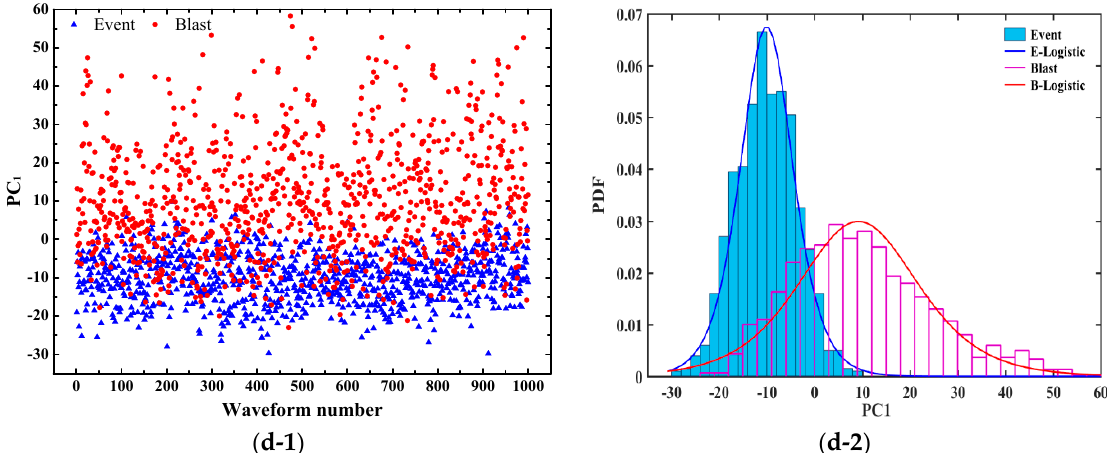
Figure 5. Distributions and the logistic probability density distributions of PC 1 of micro-seismic events and blasts for test 1 to test 4. ( a ) Test 1; ( b ) Test 2; ( c ) Test 3; ( d ) Test 4. The blue triangles and red circles indicate the micro-seismic events and blasts in the training sets, respectively.